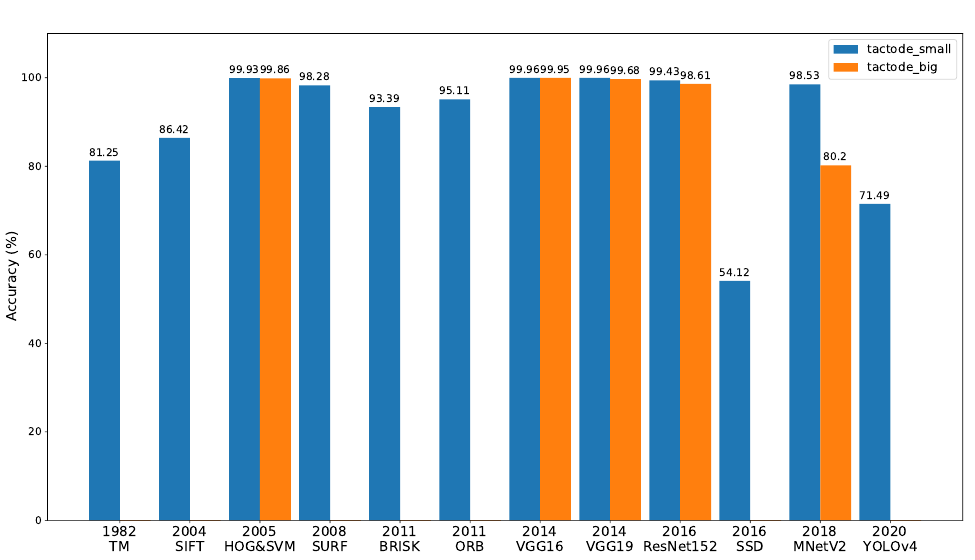
Figure 6. Timeline-like representation of the results obtained over the two test datasets with the global accuracy of all recognition